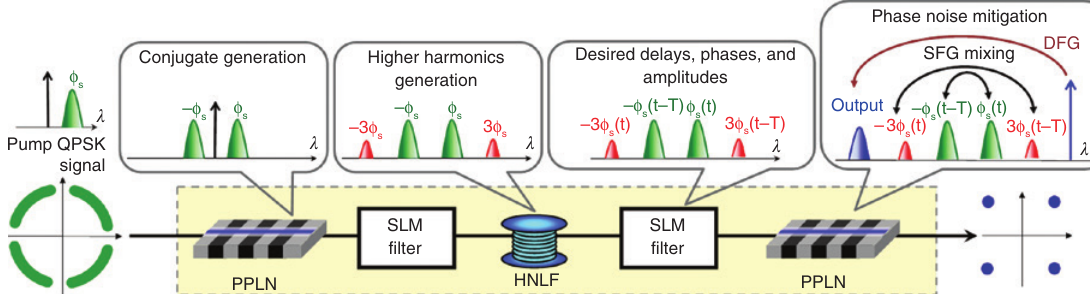
Figure 21: Non-PSA phase squeezing system design.